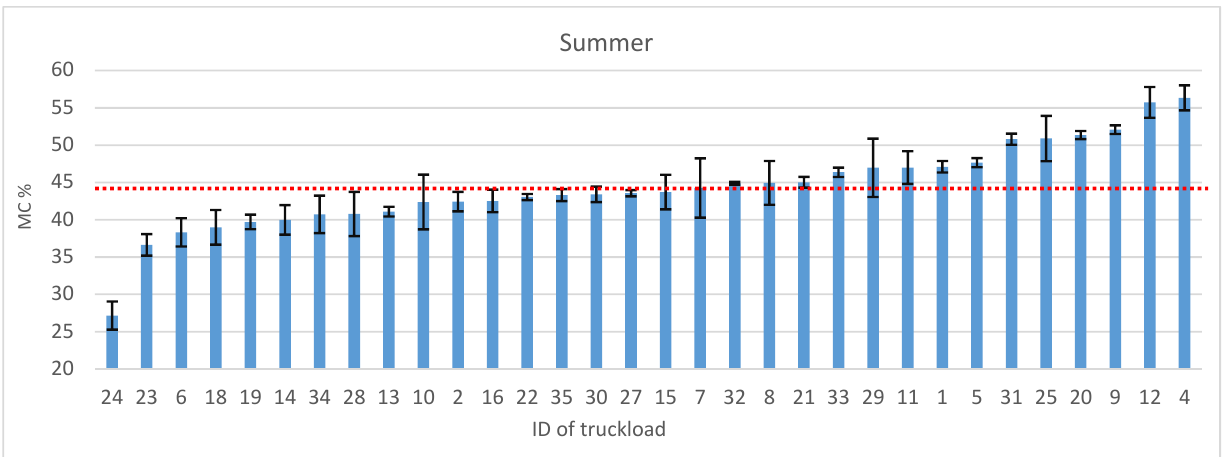
Figure 3. Average MC values of truckloads in increasing order for Summer sampling period. The red line represents the average MC value (44.3%), black bars show the SD.